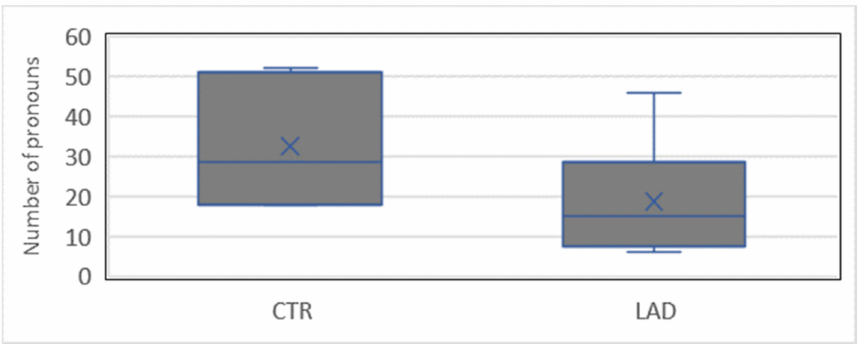
Figure 7. Range of proportions of impersonal man ‘one’ in the CTR group and the LAD